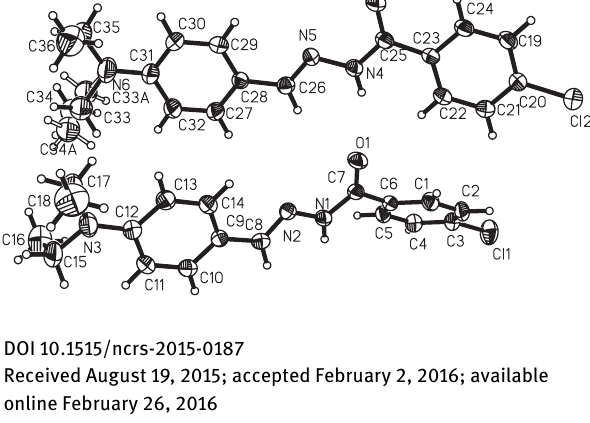
Table 2: Fractional atomic coordinates and isotropic or